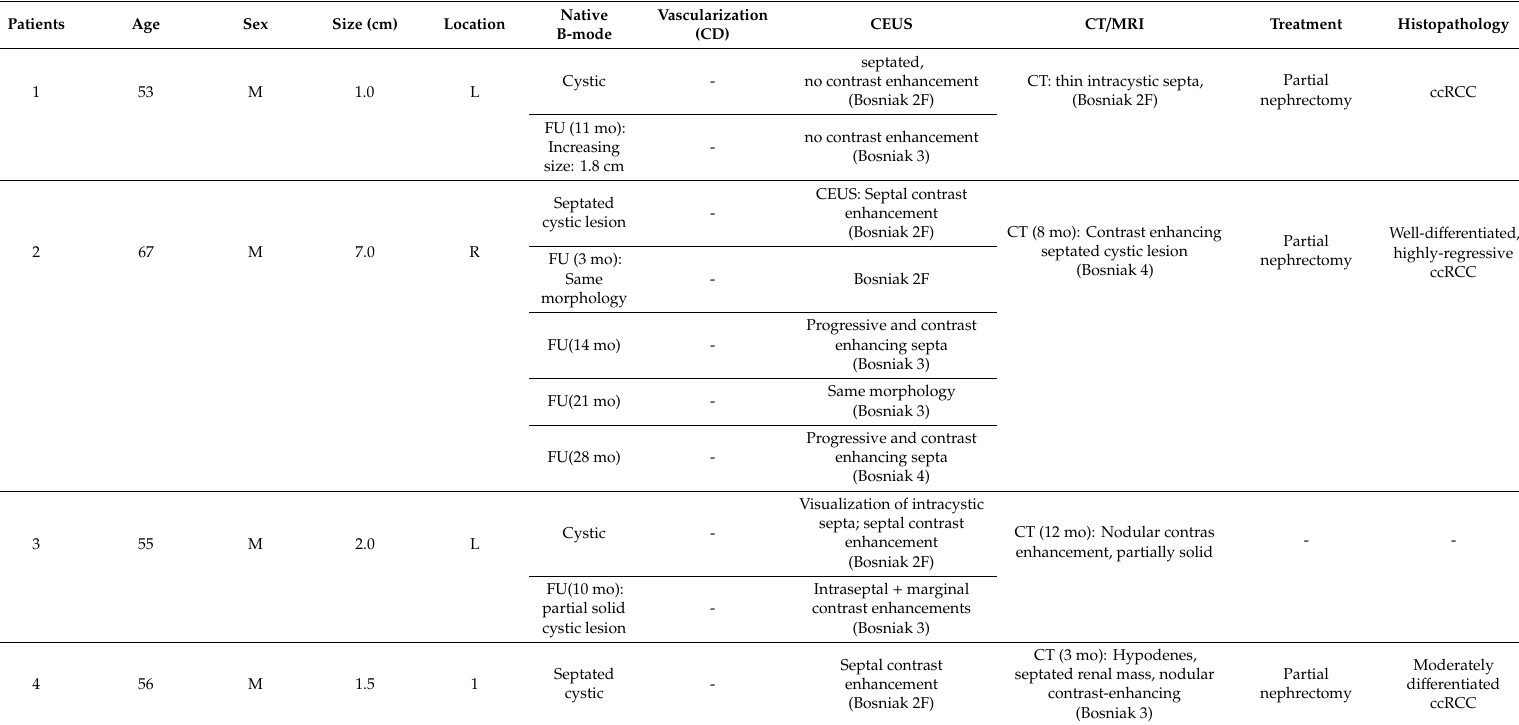
Table 1. Patients with initial Bosniak 2F lesions, which progressed during follow-up